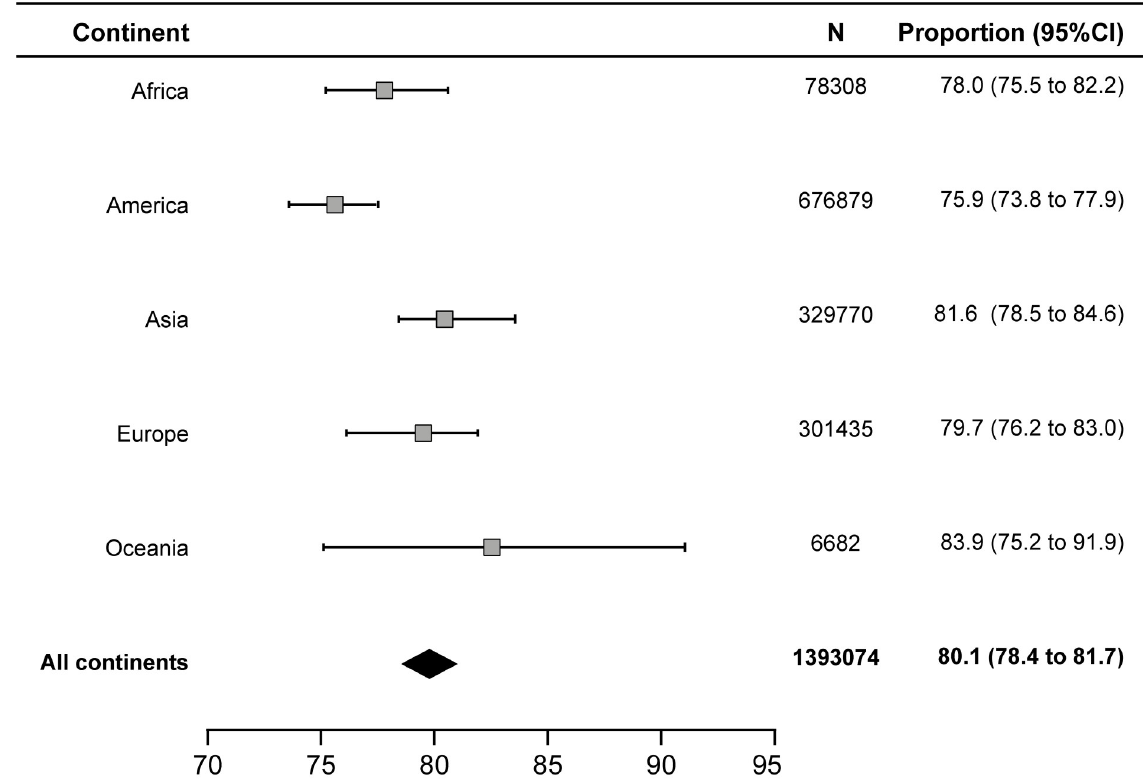
Fig 2. Pooled estimate of successful tuberculosis treatment outcome.